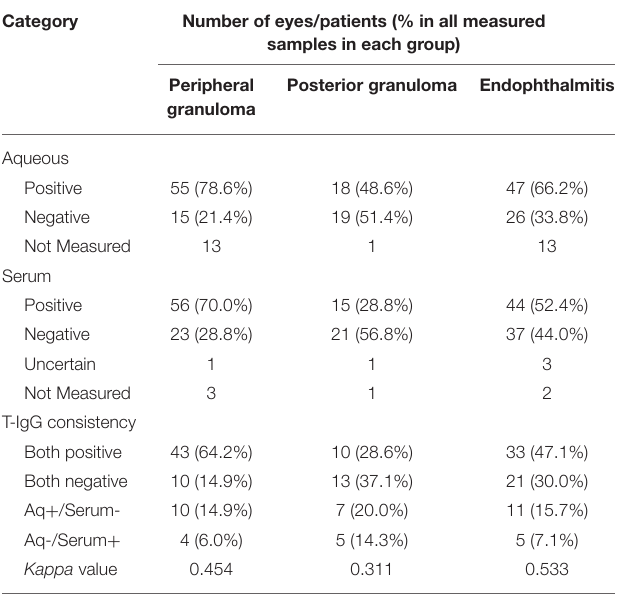
TABLE 3 | Aqueous and serum T-IgG status.